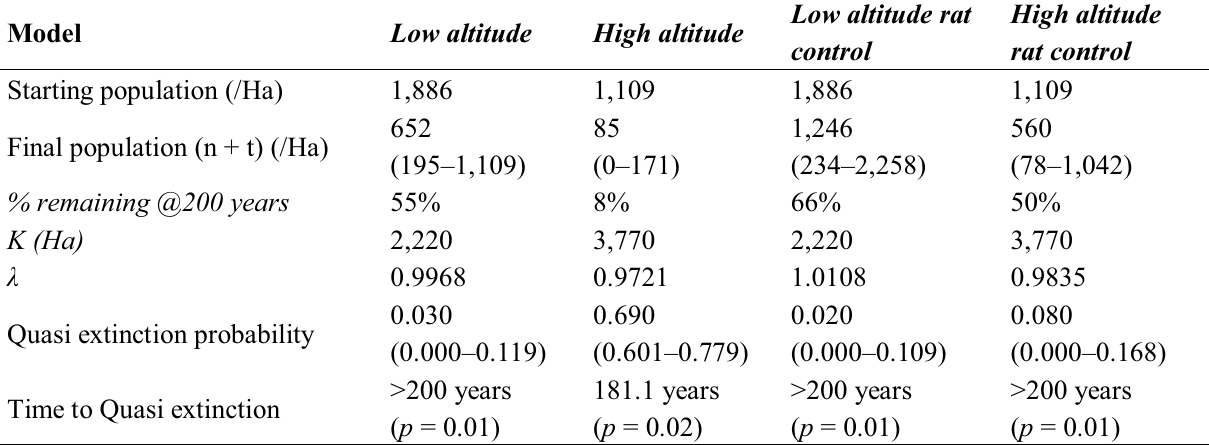
Table 6. Population model outcomes for H. cantaburyana on Lord Howe Island at different altitudes and with rat control. The carrying capacity per hectare K (Ha), growth (cid:85)(cid:68)(cid:87)(cid:72)(cid:3)(cid:11)(cid:540)(cid:15)(cid:3)(cid:68)(cid:83)(cid:83)(cid:85)(cid:82)(cid:91)(cid:76)(cid:80)(cid:68)(cid:87)(cid:72)(cid:3)(cid:73)(cid:76)(cid:81)(cid:76)(cid:87)(cid:72)(cid:3)(cid:85)(cid:68)(cid:87)(cid:72)(cid:3)(cid:82)(cid:73)(cid:3)(cid:76)(cid:81)(cid:70)(cid:85)(cid:72)(cid:68)(cid:86)(cid:72)(cid:12) , starting population size per Hectare, mean final population size (n + t) for each model, predicted percentage of initial population remaining after 200 years, probability and time to quasi-extinction (population falling below 100 individuals) with probability. For mean predicted values the range ±1 one standard deviation or the 95% confidence interval are given in brackets.